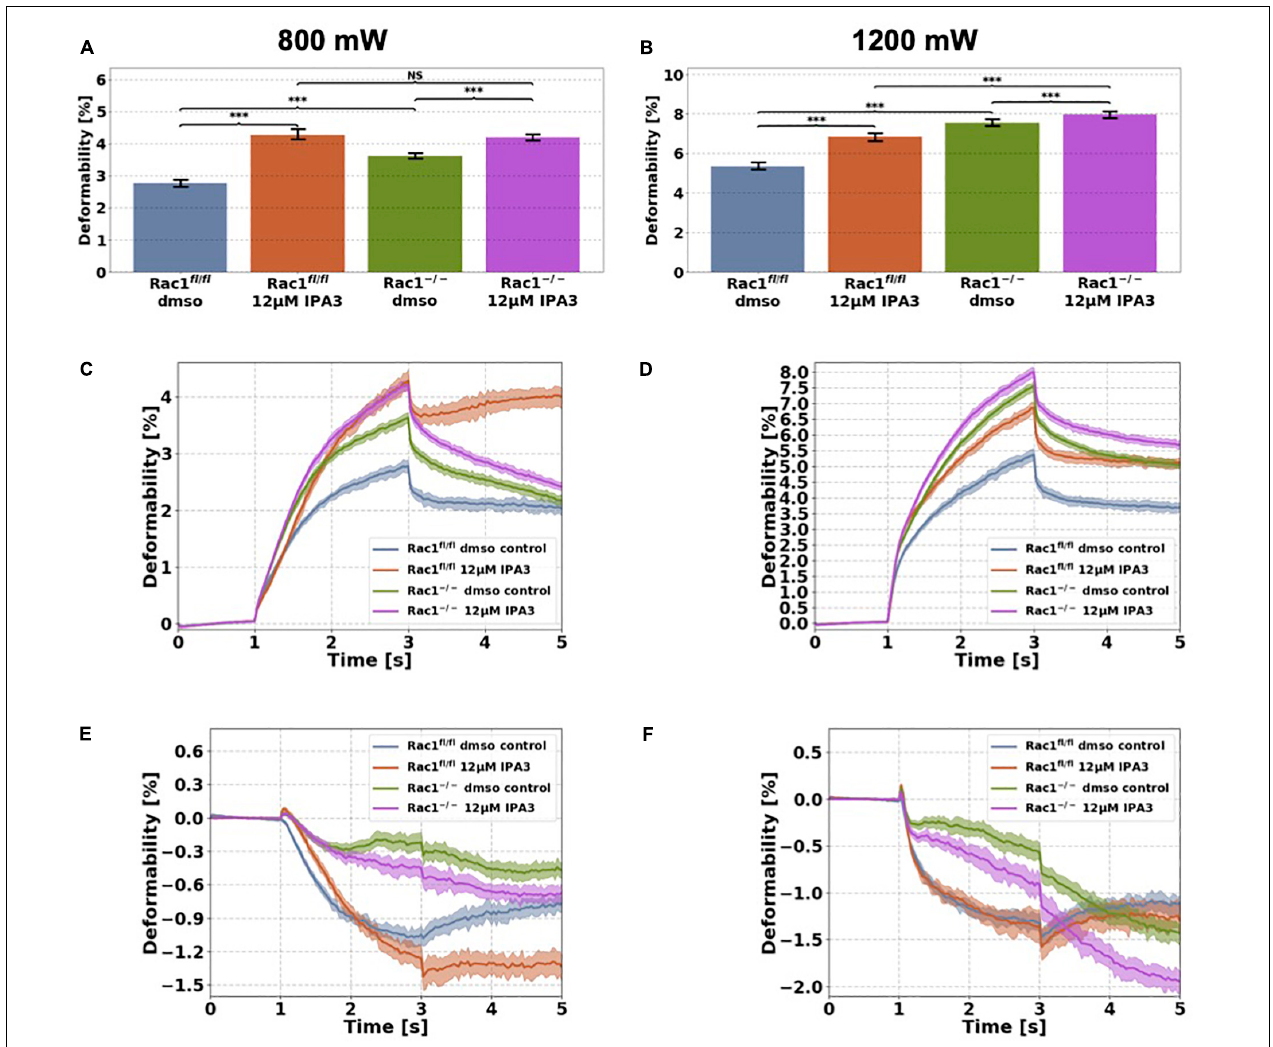
FIGURE 5 | Cellular stiffness (inverse deformability) of non-adhesive Rac1 fl / fl and Rac1 − / − cells stimulated with 12 µ M IPA3 using an optical cell stretcher. Cells are trapped at 100 mW laser powers for 1 s and then stretched for 2 s by increasing laser powers up to 800 mW (A,C,E) or 1200 mW (B,D,F) along laser beams axes. After stretching process, laser powers were reduced to 100 mW and viscoelastic relaxation was observed for 2 s. (A,B) Maximal deformation of Rac1 fl / fl is pronouncedly increased (stiffness decreased) by 12 µ M IPA3 for both laser powers. Rac1 − / − cells showed an increased maximal deformation (stiffness decreased) for 800 mW (A) and only a slightly increased deformation for 1200 mW (B) . The data are presented as median with SD. Cellular deformability along the long axis of Rac1 fl / fl and Rac1 − / − cells incubated with 12 µ M IPA3 for 2 h at laser powers of 800 mW (C) and 1200 mW (D) were presented. Mechanical behavior along the short axis of Rac1 fl / fl and Rac1 − / − cells incubated for 2 h with 12 µ M IPA3 at laser powers of 800 mW (E) and 1200 mW (F) . Data are presented as median values with confidence interval (2*SD) of 95.46%. A p -value of 0.05 is considered as statistically significant, *** p < 0.001 and NS, not